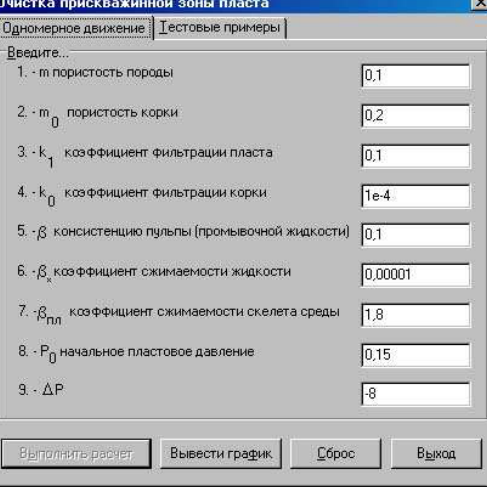
Figure 10: Baring of the well bore zone